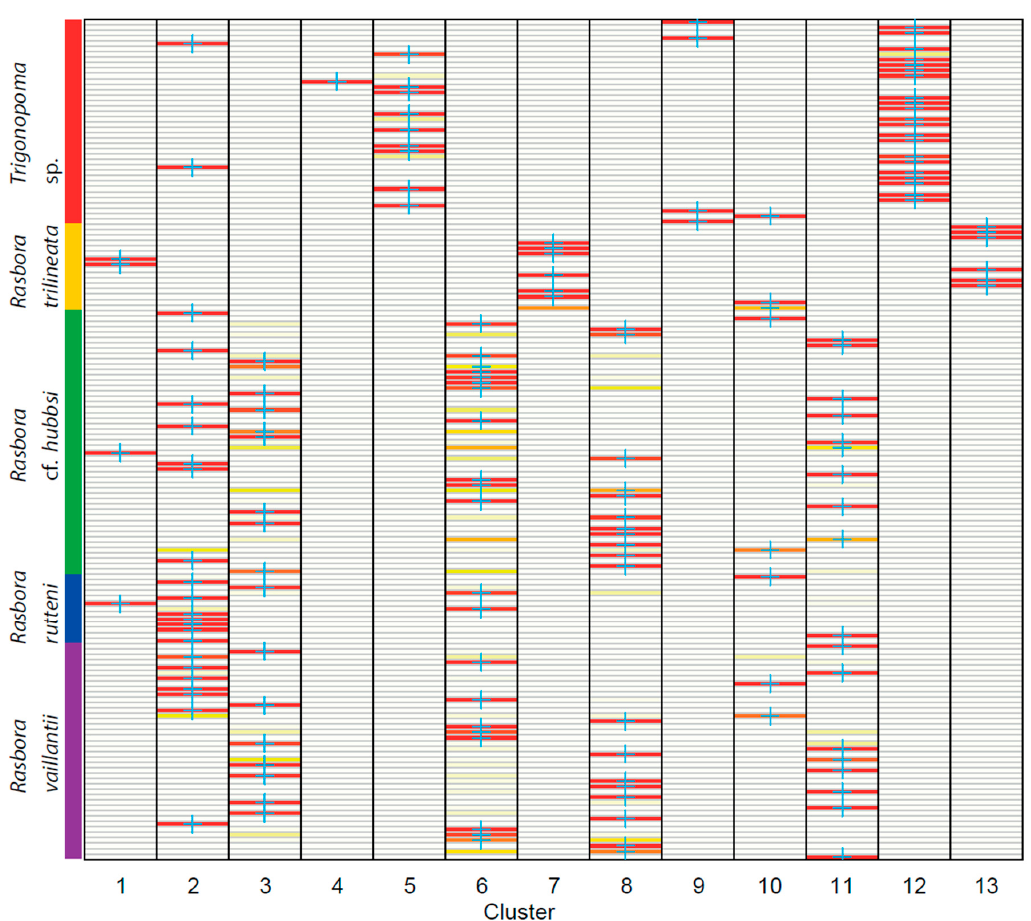
Figure 5. Assignment probabilities computed by the discriminant analysis of principal components (DAPC) of the five species to the 13 clusters calculated by a k-mean cluster algorithm. (Red) assignment probability of 100%; (orange) assignment probability of 50%; and (yellow) assignment probability of 25%.